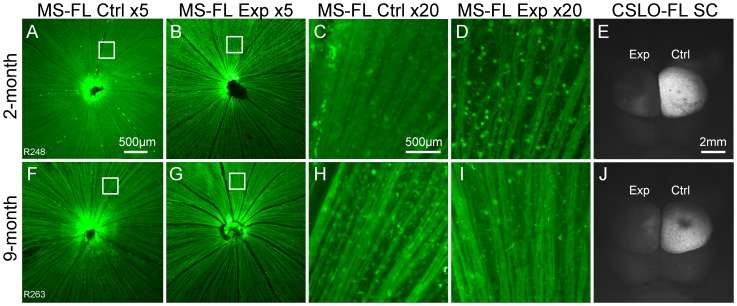
Anterograde axonal transport assay 3-weeks after chronic IOP elevation.The experimental eye results from one representative animal in the 2-month (A-E) and 9-month (F-J) age groups. Post-mortem fluorescence microscopy (MS-FL) images of the ocular fundi from the control (Ctrl; A,F) and experimental (Exp; B,G) eyes 24 h after bilateral intravitreal injections of CTB demonstrate successful CTB uptake and transport by RGCs along their axons within the RNFL to the optic disc. Higher power MS-FL images corresponding to the boxed regions show healthy, straight RGC axons in the control eyes (C,H) and wavy axons in the experimental eyes (D,I). Post-mortem CSLO-FL images of the superior colliculi (E,J) show much greater intensity and coverage of CTB fluorescence in the control side of the colliculus, indicating anterograde axonal transport to the colliculus is intact along the control pathway, but severely disrupted in the experimental pathway in both age groups. Quantitative results for the entire group are shown in Table 1. Scale bar in (A) applies to (A,B,F,G); in (C) applies to (C,D,H,I); in (E) applies to (E,J).